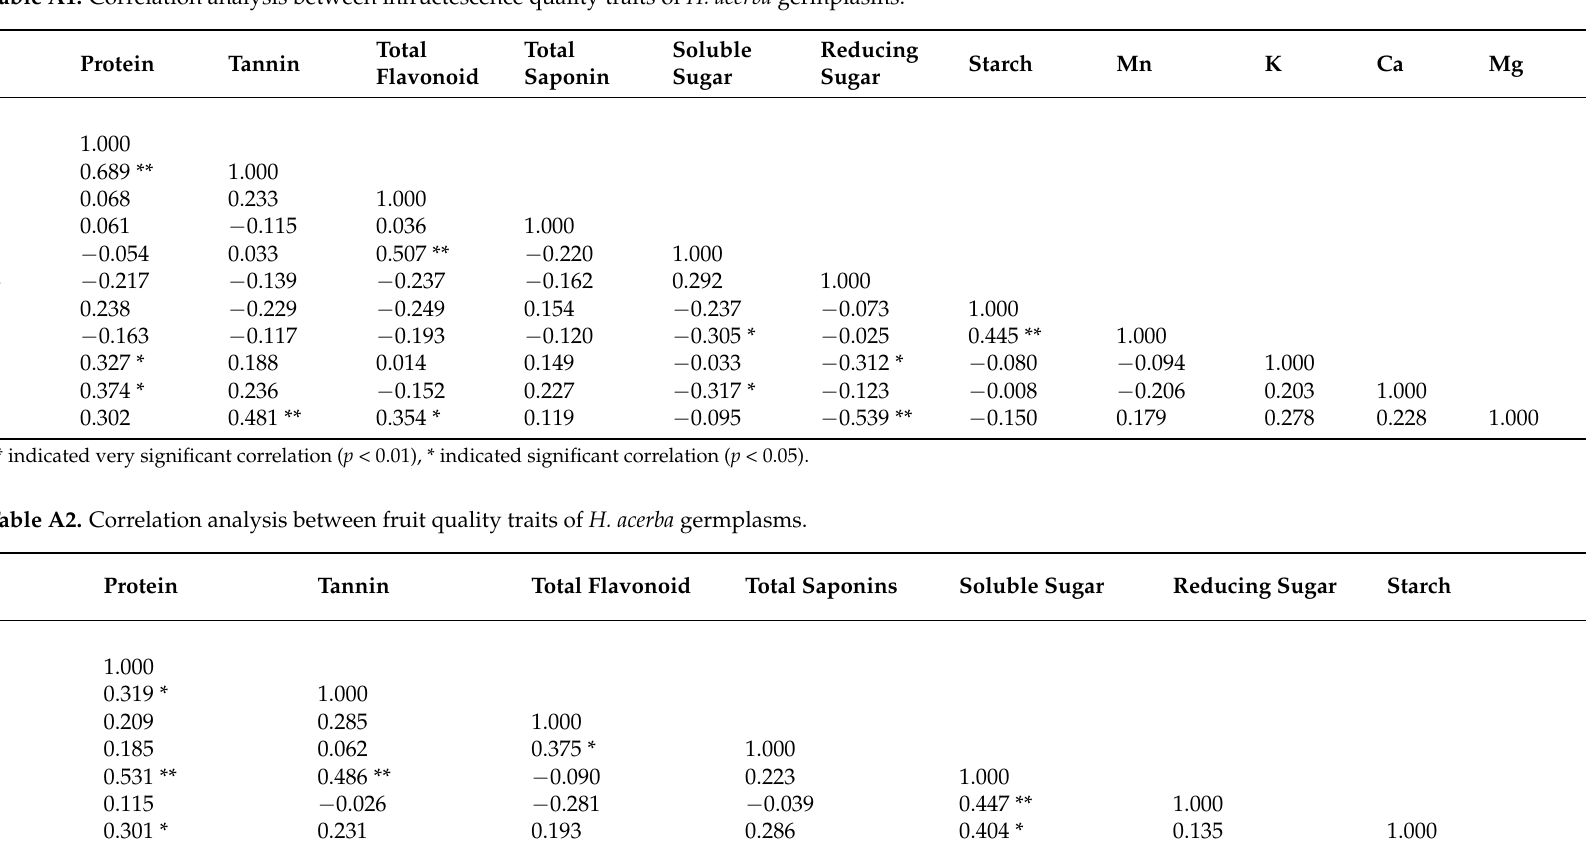
Table A1. Correlation analysis between infructescence quality traits of H. acerba germplasms.